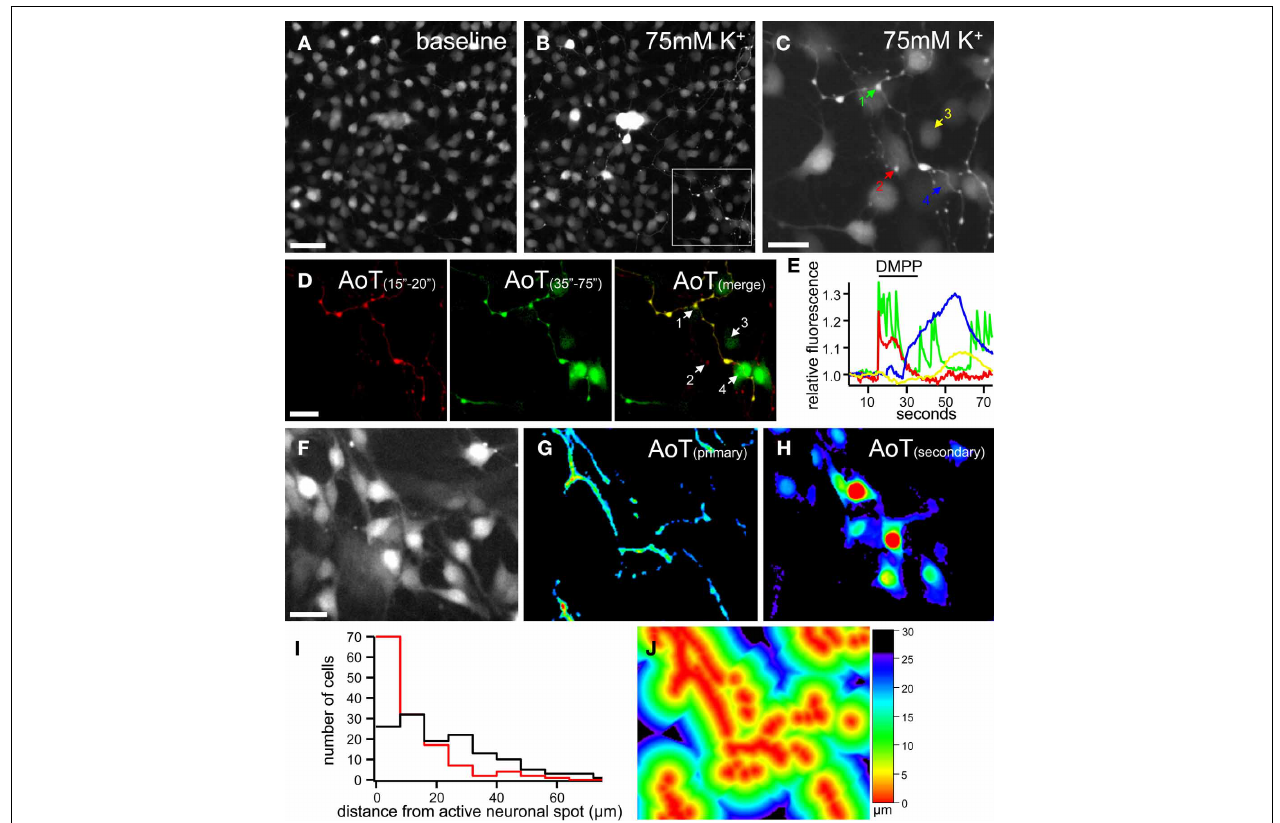
FIGURE 3 | Ca 2 + imaging of enteric neuron-glia interactions in primary enteric nervous system cultures. (A,B) Gray scale images of a patch of cultured mouse enteric neurons and glia loaded with Fluo4 at rest (A) and depolarized by 75mM K + application 5s, (B) . Note the large increase in fluorescence of the group of neuronal cell bodies in the center of the image. (C) Magnification of the frame indicated in (B) showing in detail the neuronal fibers and varicosities as depolarized by 75mM K + . (D) Activity over time (AoT) images of the primary (red) and secondary (green) responses to nicotinic receptor stimulation (DMPP, 10 μ M, 20s) of the same group of cells as indicated in (C) . (E) Ca 2 + responses of 2 neuronal boutons (1, green and 2, red) and 2 glial cells (3, yellow and 4, blue) upon DMPP application [color-coded numbers in (C) and numbers in (D) ]. Note